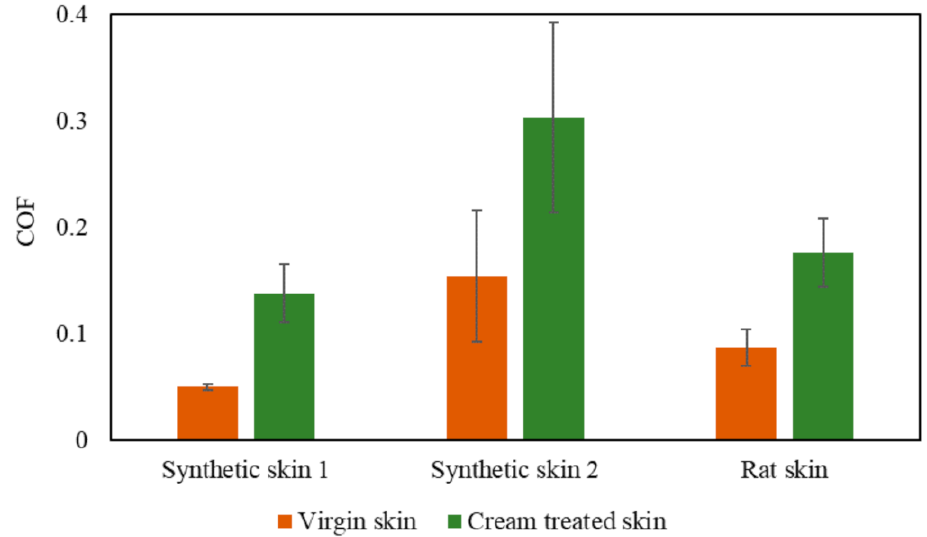
Figure 7. COF values for nanoscale tested synthetic skins and rat skin with and without cream.